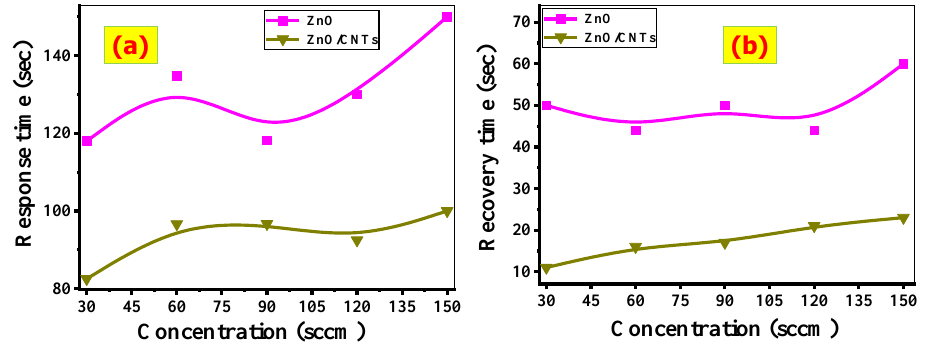
Figure 8. ( a ) Response and ( b ) recovery times for ZnO and ZnO/CNTs films.